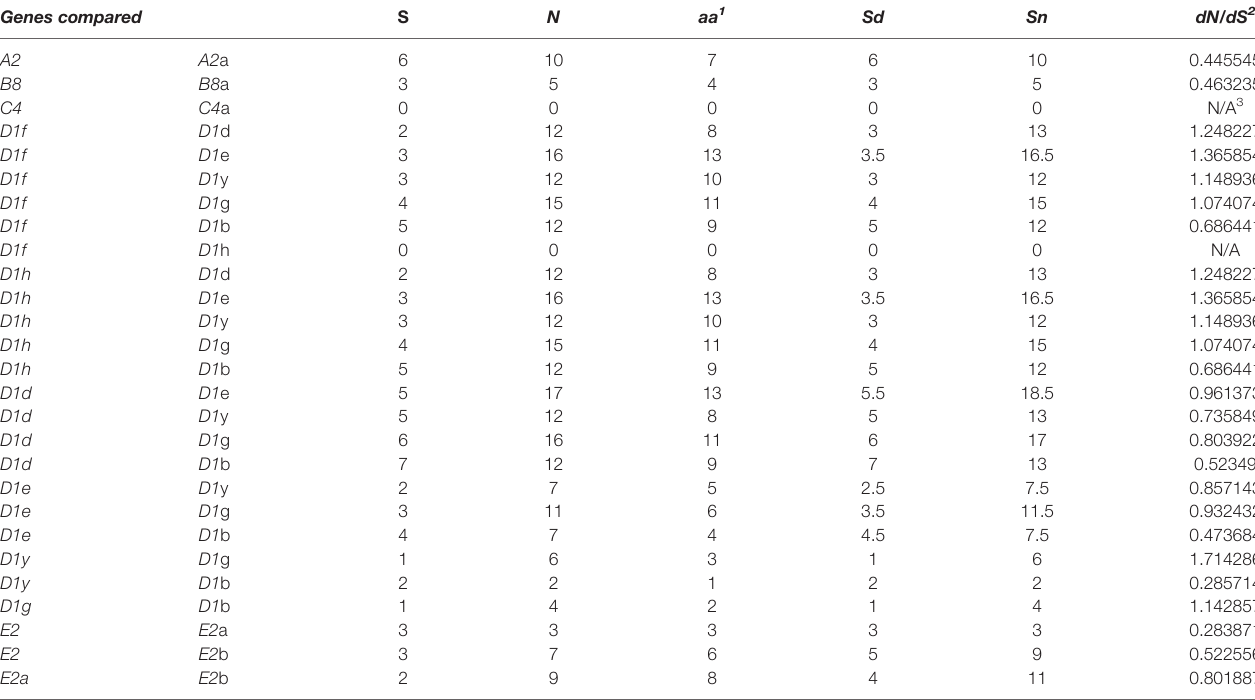
TABLE 4 | dN/dS values for genes with the same element pattern show that some are undergoing positive selection while others are undergoing purifying selection. Genes